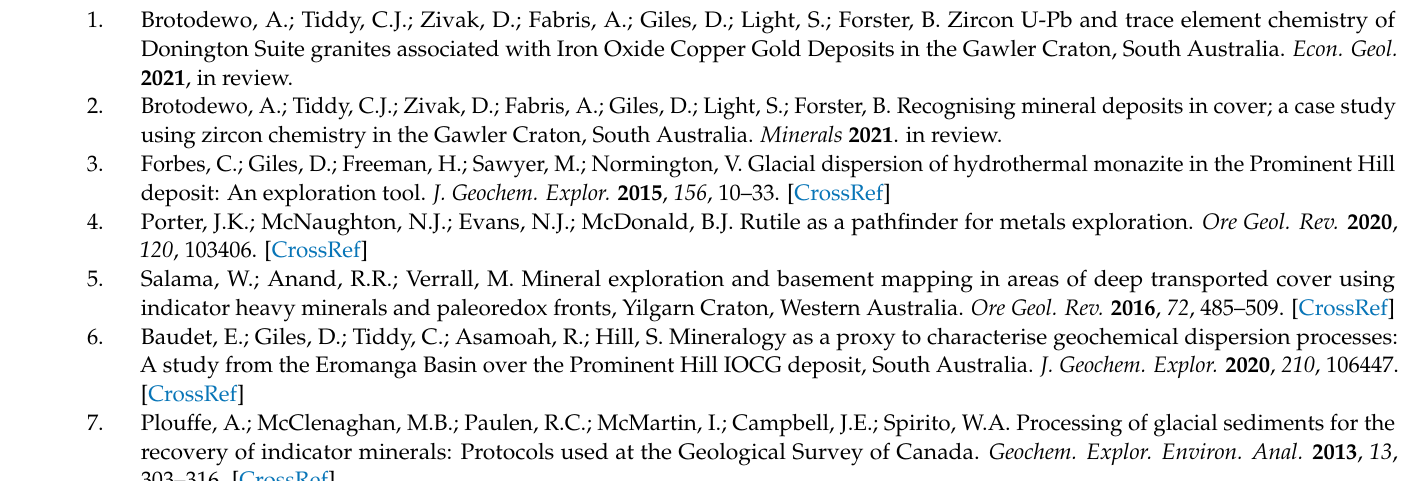
analysis, the ‘shared’ background fit option in Probe for EPMA was used across the list of elements. In simple background regions, a traditional 2-point linear fit was still used. For more complex regions of the spectrum, such as in the case some of the REE, multipoint or ‘shared’ fits were used to accurately model the background continuum and/or avoid off peak